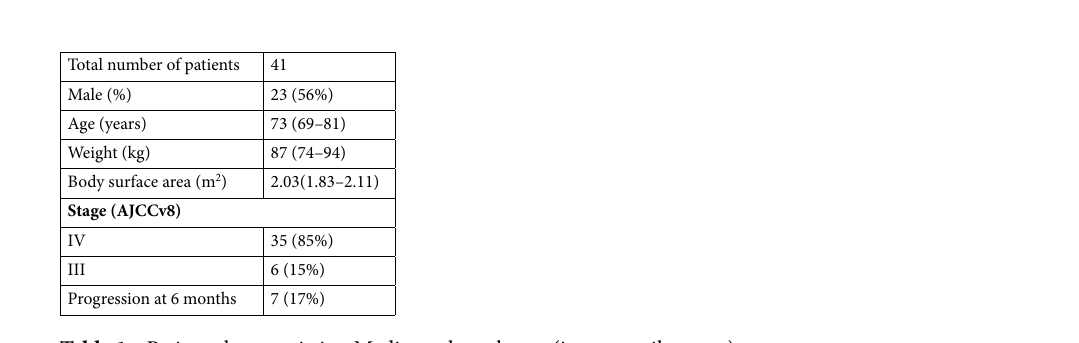
Table 1. Patient characteristics. Median values shown (interquartile